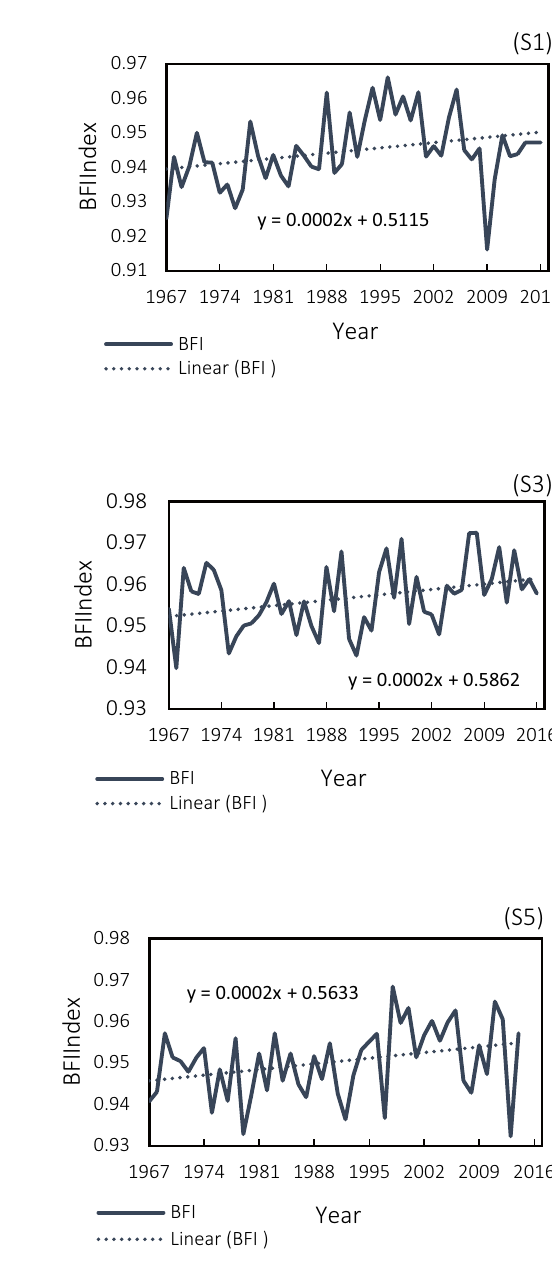
Figure 5. The trend of annual precipitation, Baseflow index, and runoff in the subbasins S1, S3, and S5 of the Dez